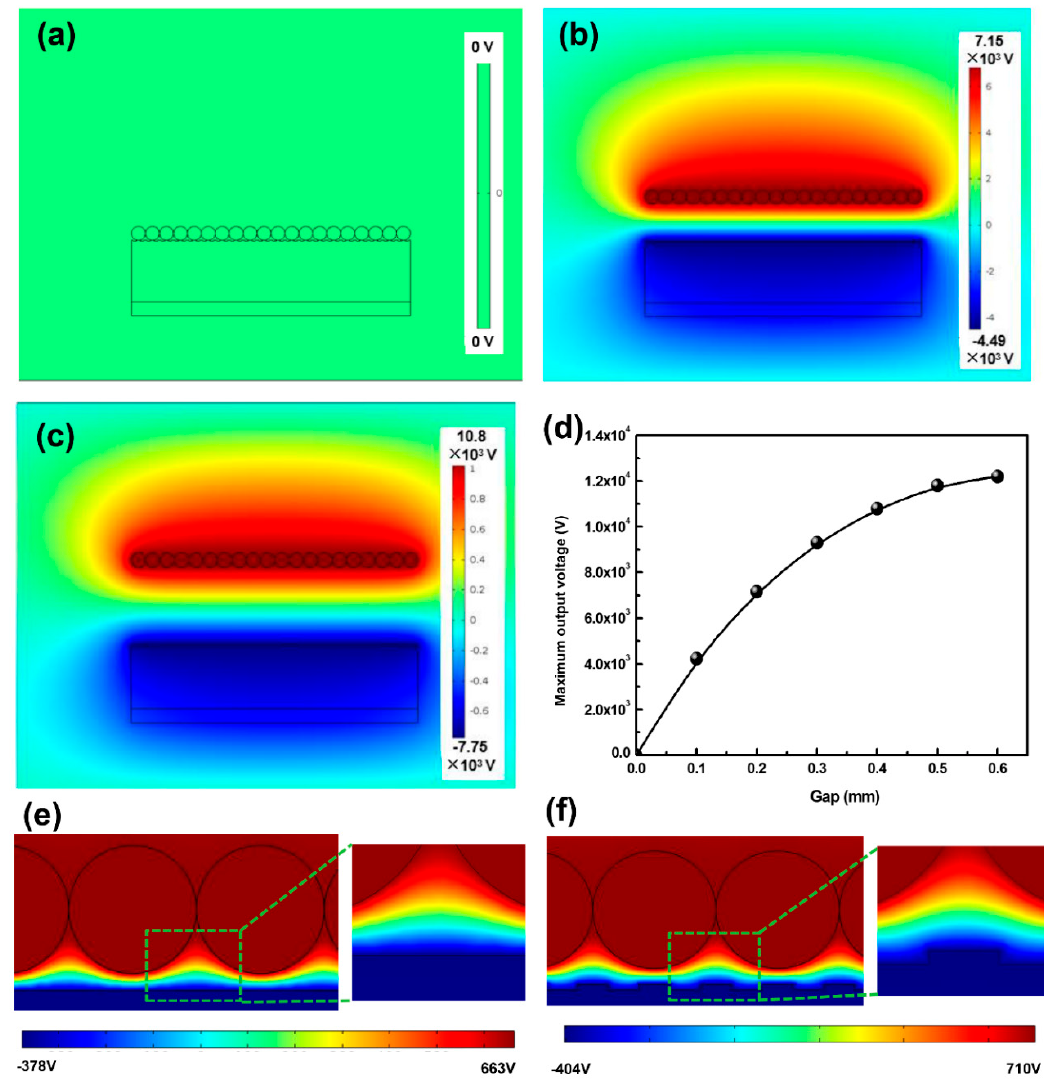
Figure 5. ( a – c ) Finite element simulation of the potential distribution in the T-TENG for different states. ( d ) The simulated relationship between the gap and maximum output voltage. ( e , f ) Potential distributions of T-TENG with the flat and sandpaper-induced surficial structures.